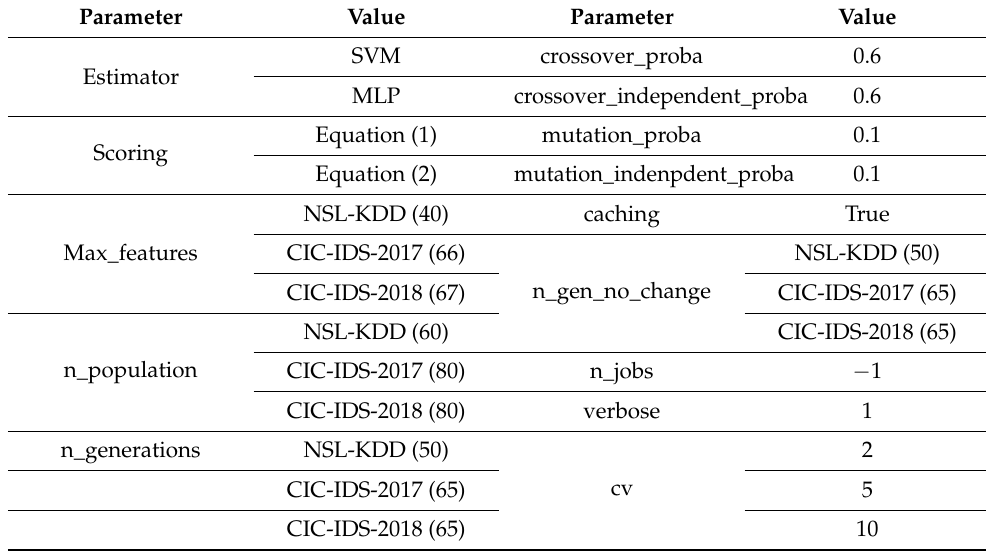
Table 5. Parameters of